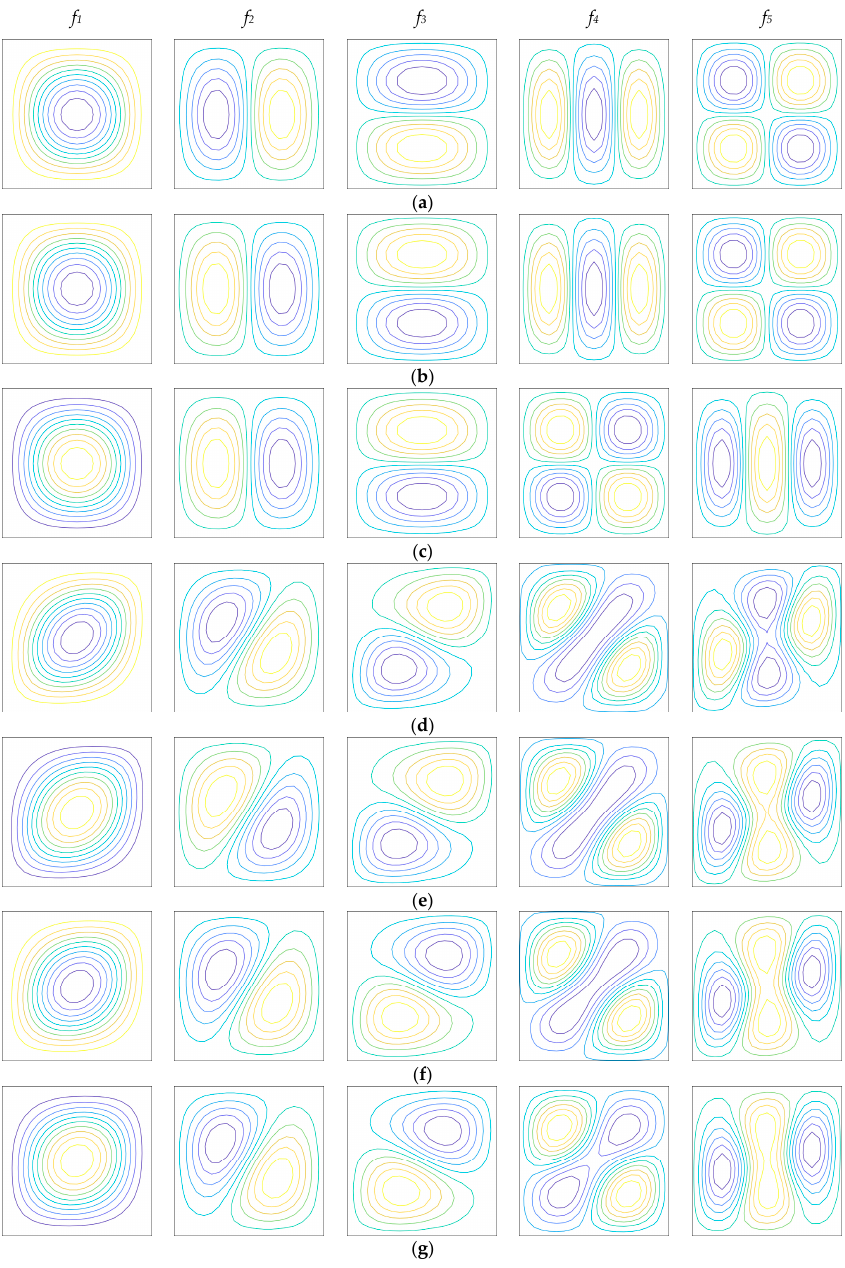
Figure 10. First five mode shapes of the mechanical configurations defined in Table 4: ( a ) Case 1; ( b ) Case 2; ( c ) Case 3; ( d ) Case 4; ( e ) Case 5; ( f ) Case 6; ( g ) Case 7.